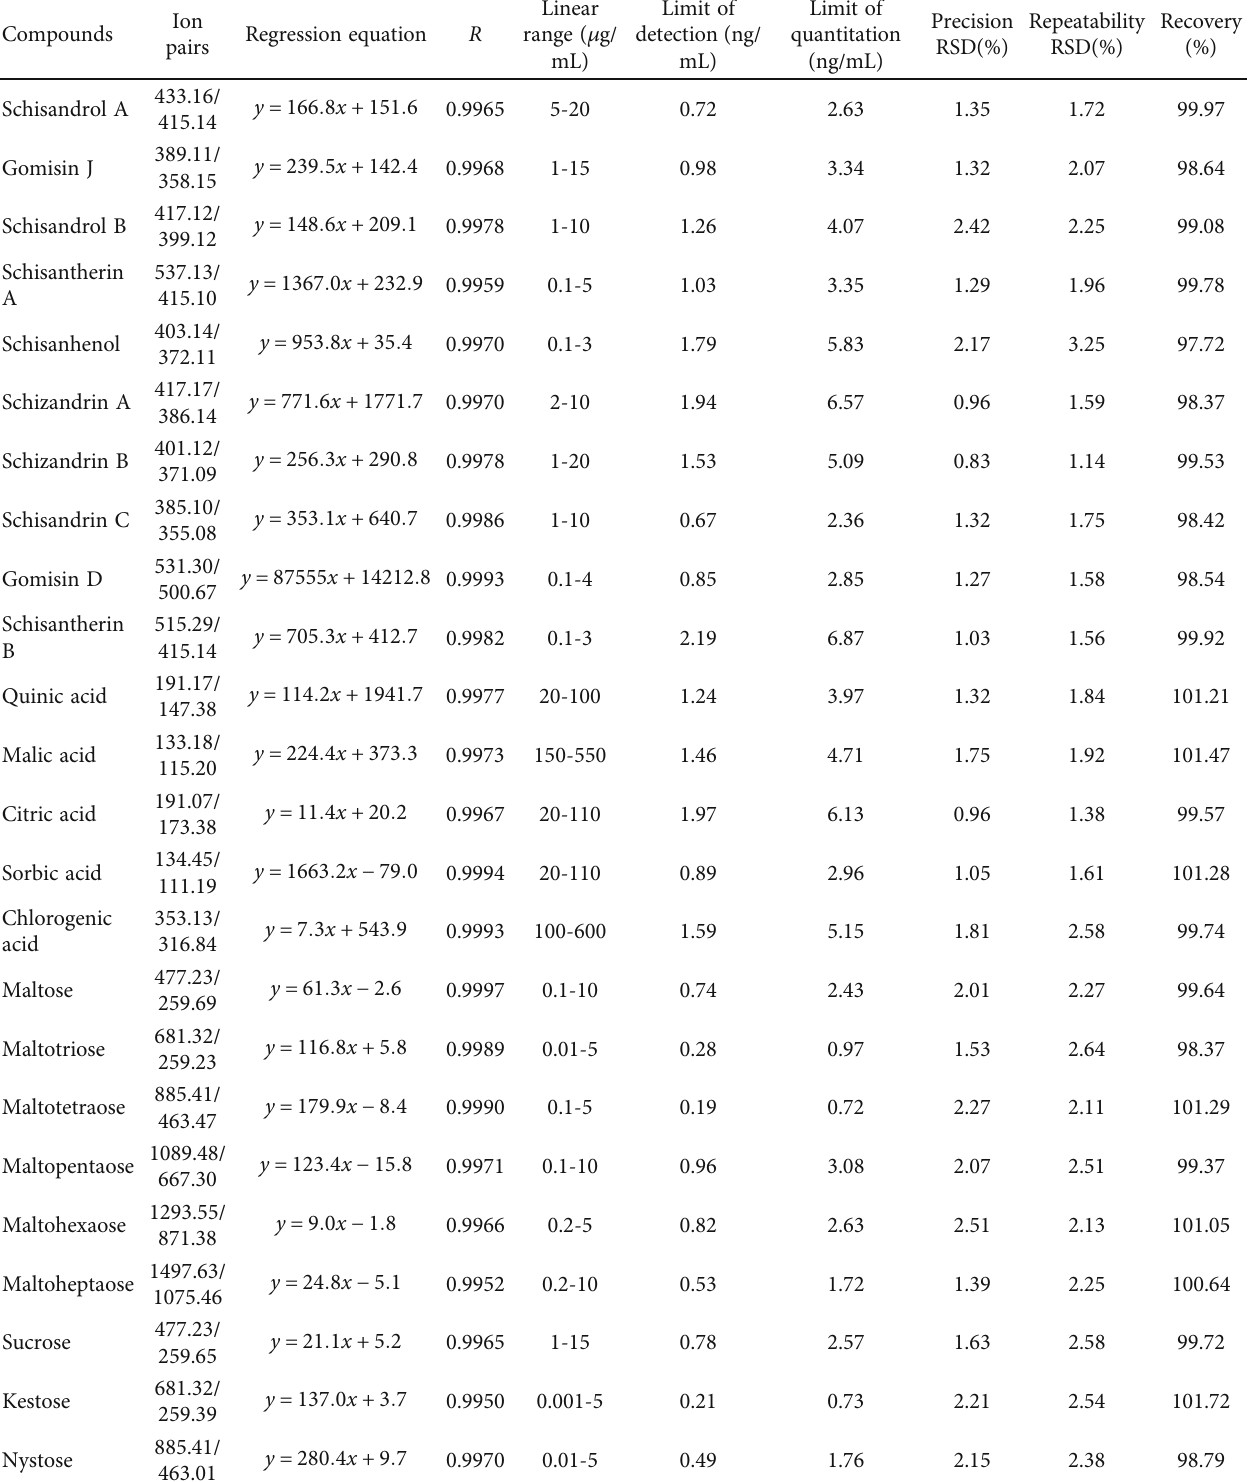
Table 2: Validation of quantitative UPLC-QQQ-MS of 10 lignans, 5 organic acids, and 9 oligosaccharide references in Schisandra chinensis. Ion Compounds Regression equation R pairs